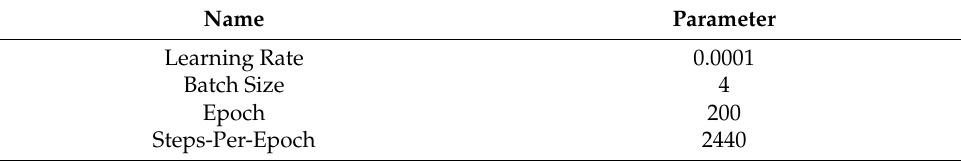
Table 3. Deep learning model training